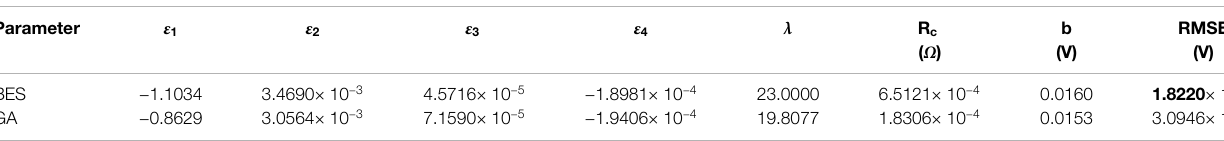
Bold values represents the best results.